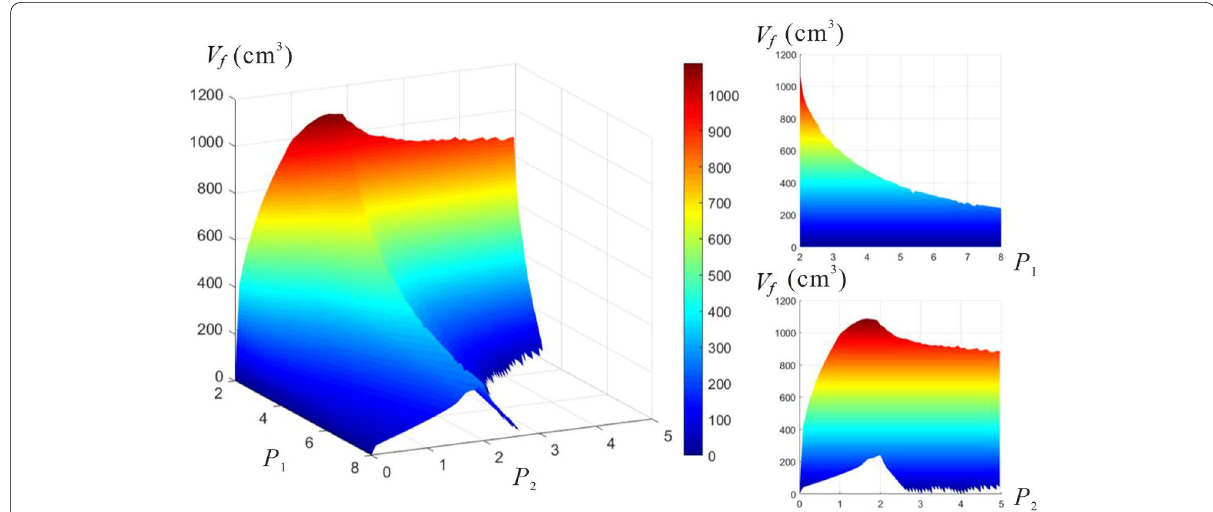
Figure 12 Volume of the workspace of the full-actuated finger 2